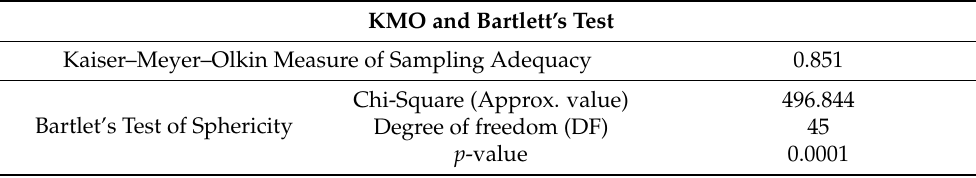
Table 2. Kaiser–Meyer–Olkin (KMO) and Bartlett’s sphericity test.